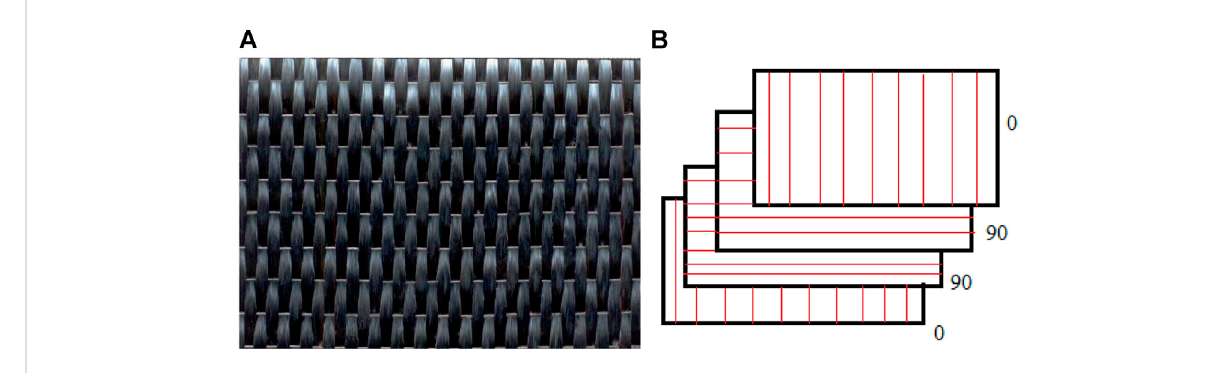
FIGURE 3 Sample of plies (A) Carbon/Epoxy 0 ° (B) Sample of [0/90 2 /0] con fi